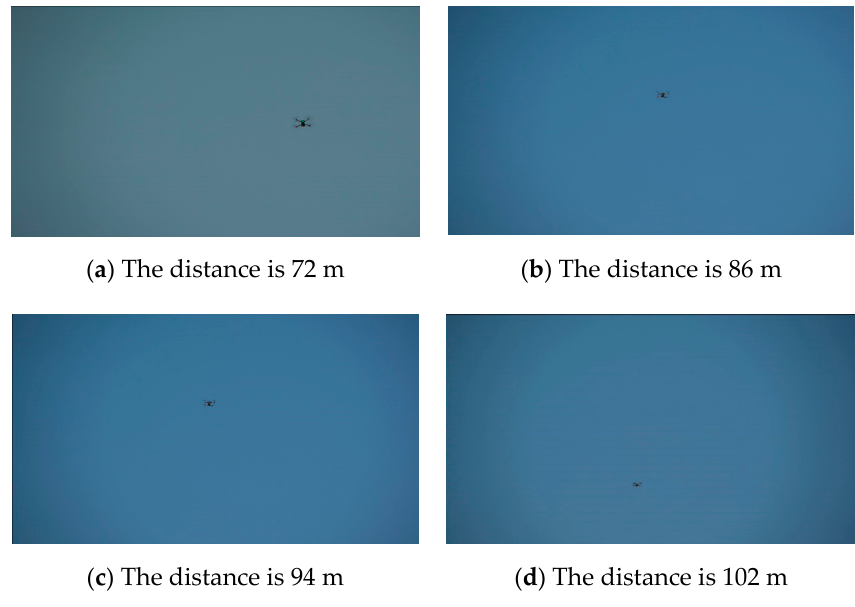
Figure 13. Tests of drone flight altitudes (on a sunny day).